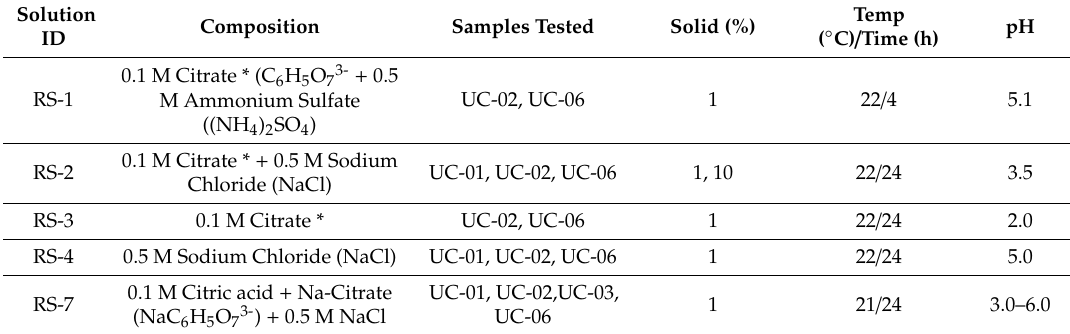
Table 3. Leaching solutions and conditions used in benchtop experiments.